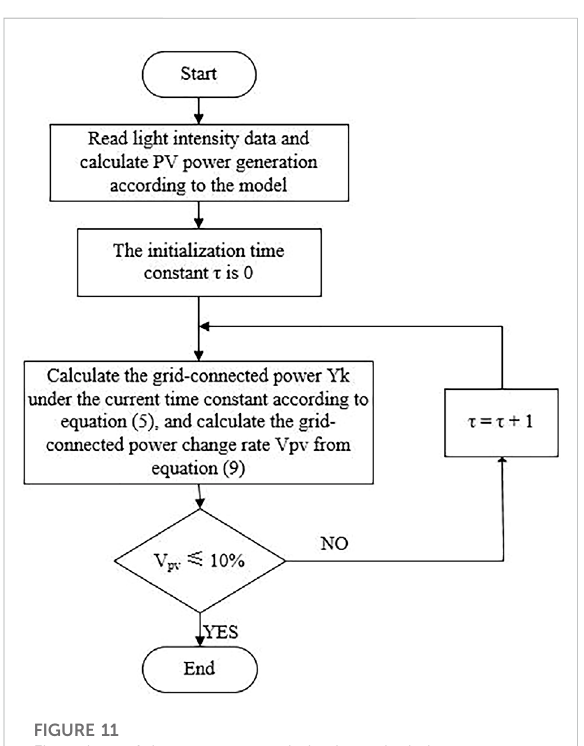
TABLE 3 Basic data of a PV